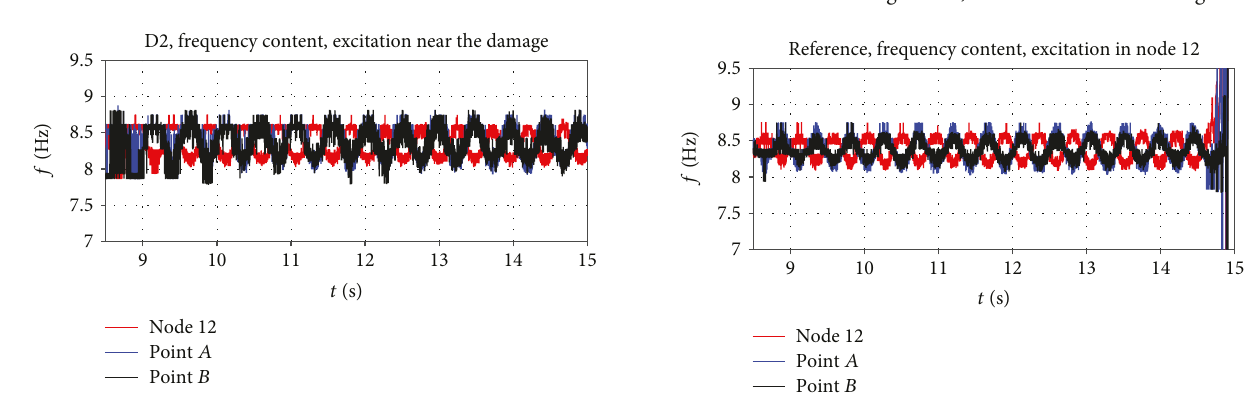
Figure 60: Undamaged case, excitation near the damage.